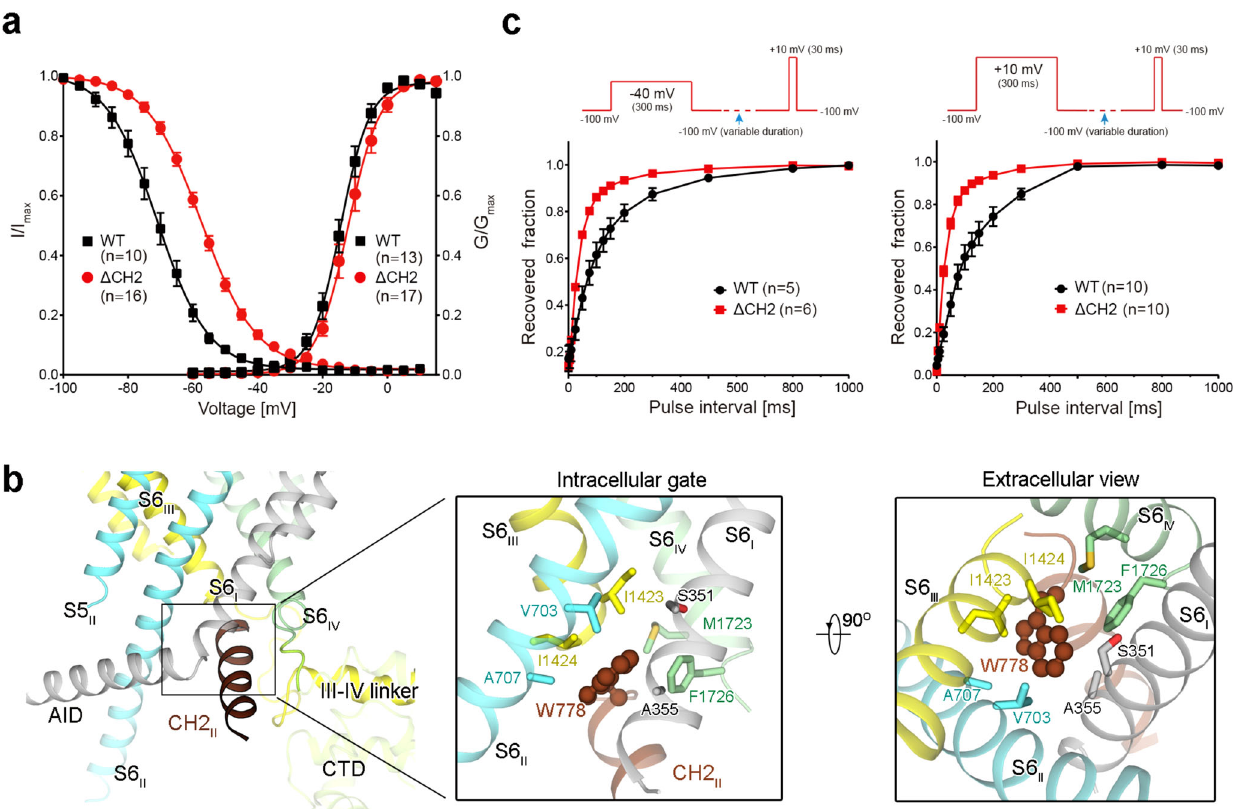
Fig. 2 | CH2 II stabilizes an inactivated state of the channel. a Deletion of the entire CH2 II segment (mutant named as Δ CH2) did not affect channel activation, but led to a pronounced right shift in the steady-state inactivation. Half-maximal activation: V 1/2 (WT) = − 14.7±0.3mV, V 1/2 ( Δ CH2) = − 12.3±0.2mV; Half-maximal inactivation: V 1/2 (WT) = − 70.9±0.1mV, V 1/2 ( Δ CH2) = − 57.3±0.1mV. All data are presented as mean±SEM. The number of tested cells is labeled in parentheses. Source data are provided as a Source Data fi le. b CH2 II (colored chocolate) is positioned right beneath the intracellular gate and surrounded by multiple intra- cellular segments. Inset: CH2 II tightens the closed intracellular gate. Trp778 (cho- colate sphere) at the beginning of CH2 II helix interacts with gating residues